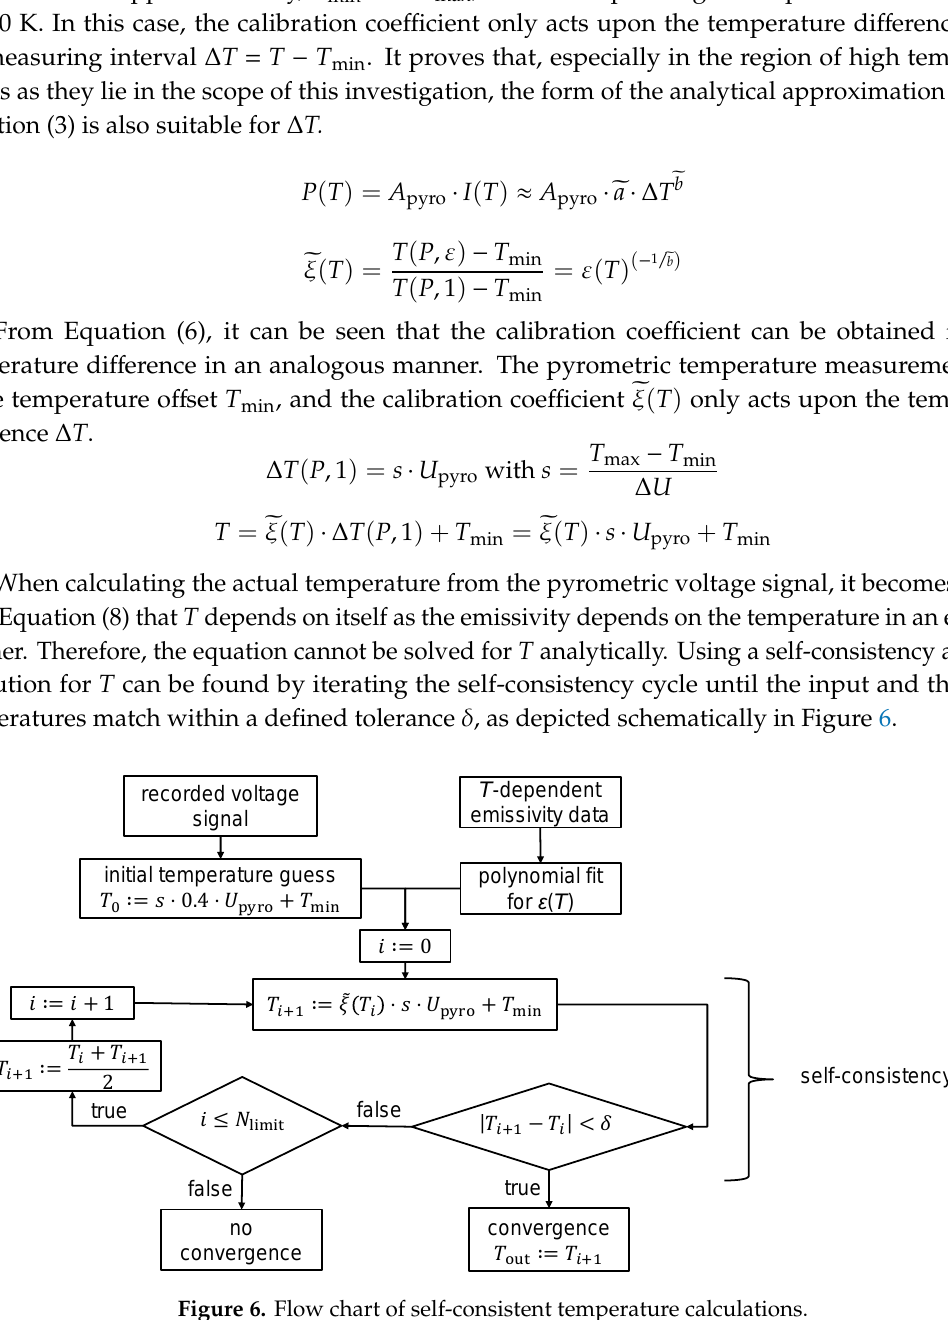
Figure 7. Influence of positioning errors on the pyrometric measurements: ( a ) geometric deviation of the measuring spot, and ( b ) resulting relative temperature deviation exemplarily for the emissivity of tantalum. For small-band pyrometers, the measured temperature depends strongly on the overlap between the measuring spot and the area of interest. An insufficient overlap has a drastic impact on the outcome of the measurement, as can be seen in Figure 7 b for the example of the emissivity of tantalum (Ta). It is important to mention that the relative error increases for high temperatures as the deviation